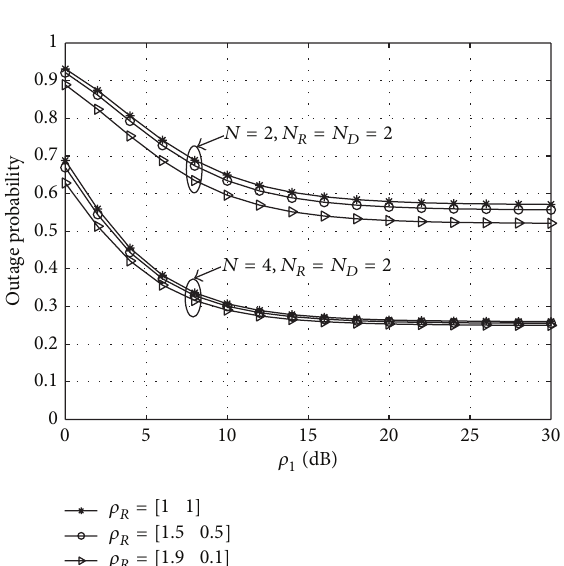
Figure 3: Impact of interference power distribution on the outage performance of the AF relaying system ( 𝜌 2 = 0 dB, 𝜌 𝐷 = 𝜌 𝑅 , 𝛾 0